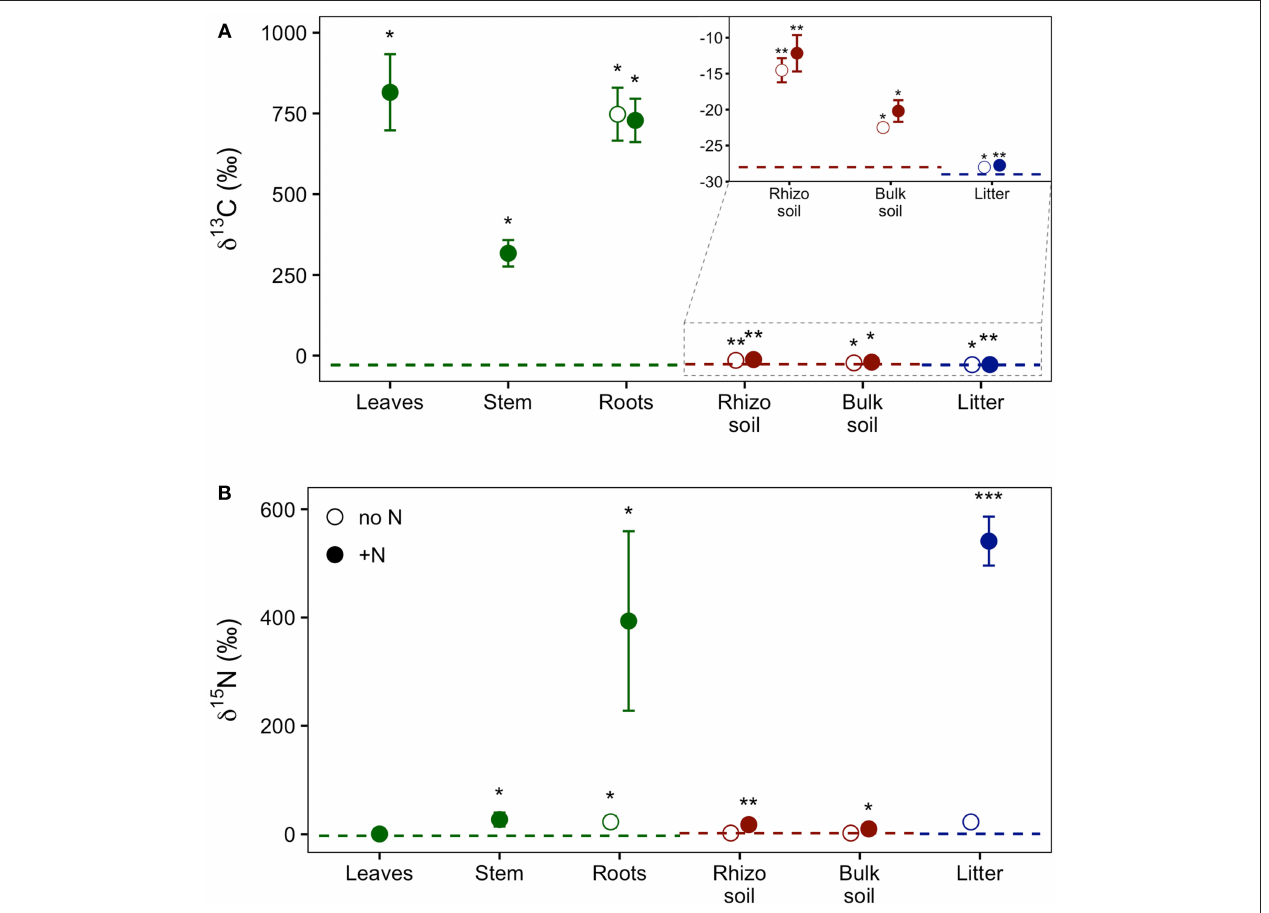
FIGURE 3 | Relative enrichment of (A) 13 C and (B) 15 N isotopes in plant, soil, and litter samples 24h after 13 C-CO 2 labeling of plants and 48h after addition of 15 N-labeled NH 4 and amino acids to litter compartments, indicating transfer of these supplies through the experimental system. Colors indicate the experimental system parts, i.e., plant (green), soil (red), and litter (blue). Dashed lines represent natural abundance values (mean of the respective system part). Symbols show results from dual-labeled ( 13 C and 15 N) plant boxes. Open circles, untreated side of the box; closed circles, N-treated side. This “side” designation refers only to roots, litter, and soil, as aboveground plant parts (i.e., leaves and stem) are connected to both sides. Error bars represent standard error. Asterisks indicate significant difference from natural abundance (* p < 0.05, ** p < 0.01, *** p < 0.001; Mann-Whitney U -test; n =